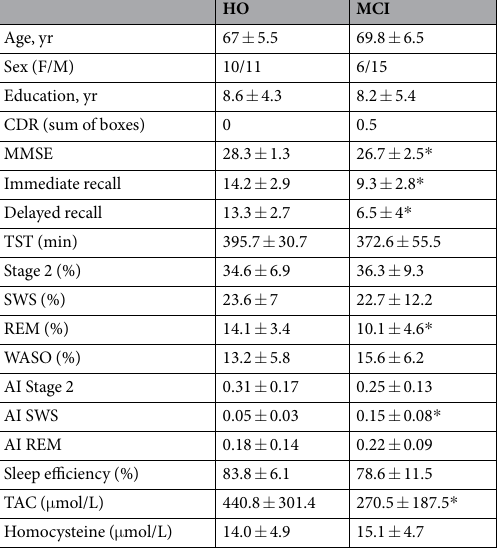
Table 1. Demographic, cognitive, sleep, and blood markers. Results are expressed as mean ± standard deviation. CDR: Clinical Dementia Rating; CDR = 0: no dementia; CDR = 0.5: questionable or very mild dementia; MMSE: Mini-Mental State Examination; TST: total sleep time; WASO: wake after sleep onset; SWS: slow-wave sleep; REM: rapid-eye movement sleep; AI: arousal index. * The statistical test for group differences reached significance ( P < 0.05).